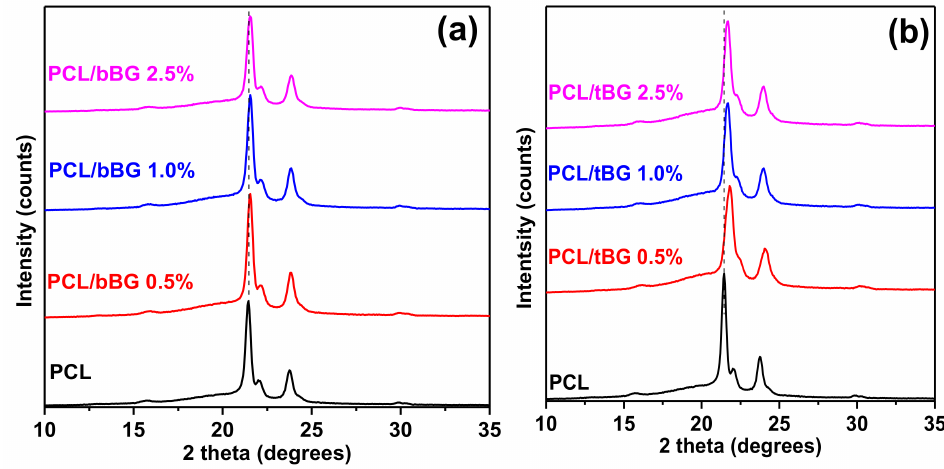
Figure 9. X-ray diffraction patterns of ( a ) PCL/bBG nanocomposites and ( b ) PCL/tBG